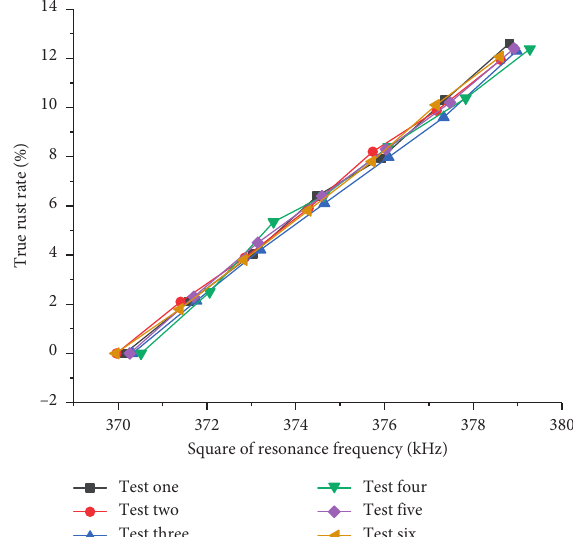
Figure 7: Relationship between square of resonance frequency and corrosion rate.